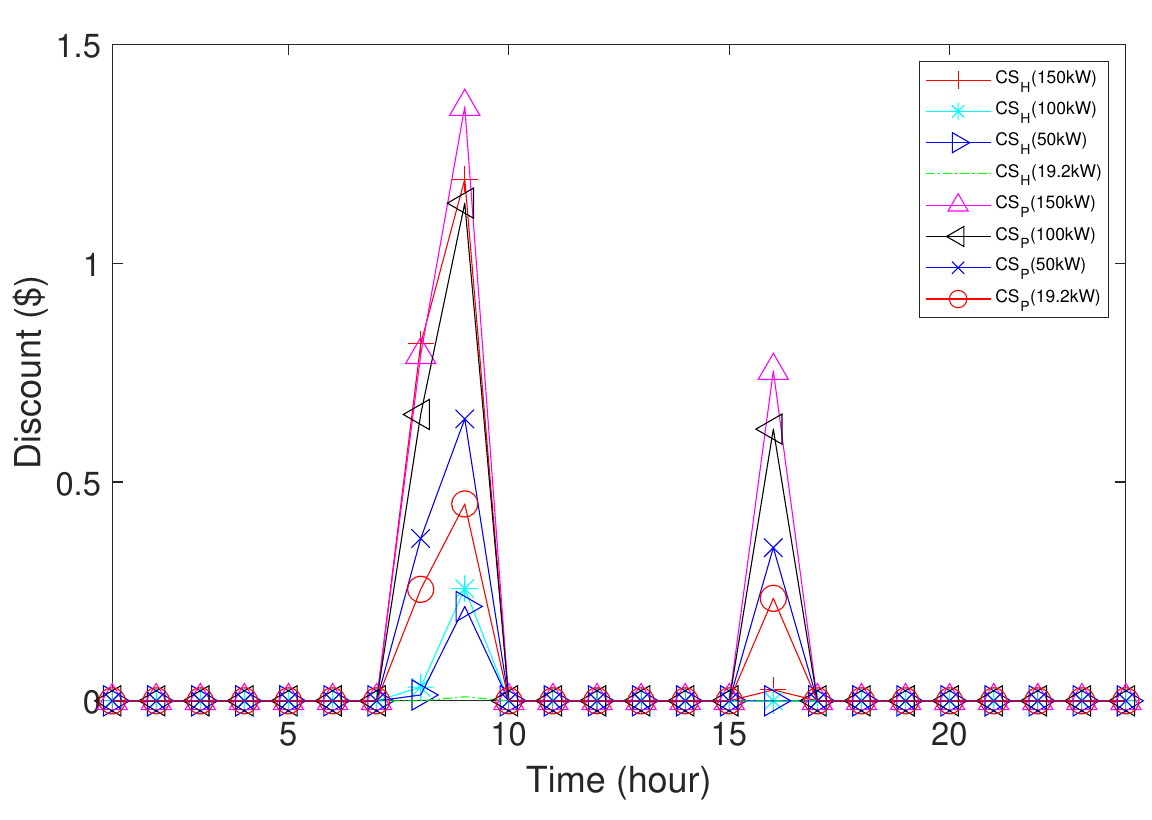
Figure 8. Average offered discount in CSs in the case of